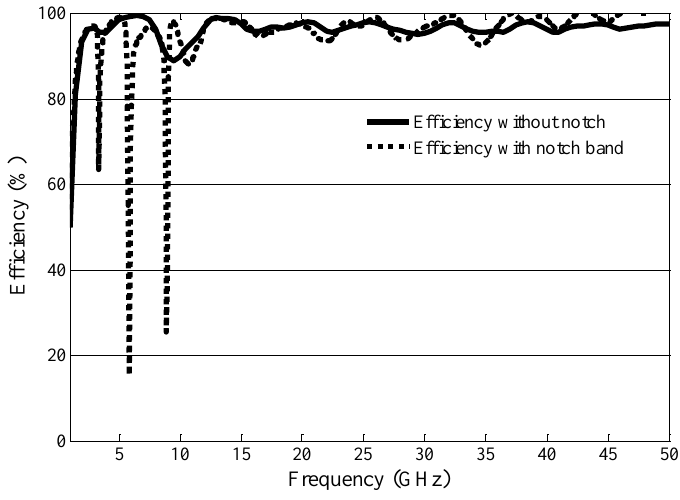
Figure 14. The plot of efficiency plot without and with notch bands.